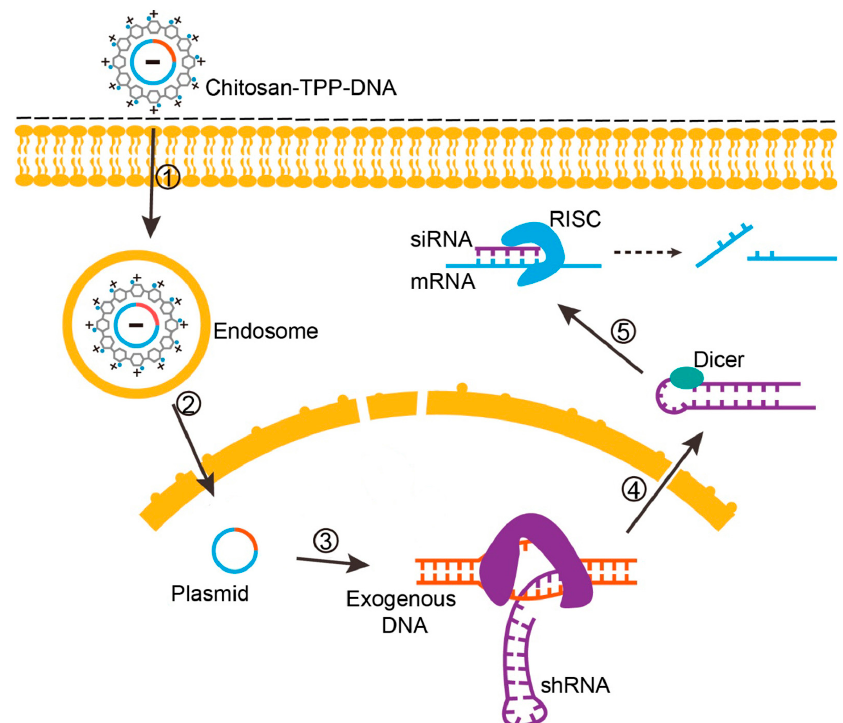
Figure 5. Cellular events associated with chitosan-based plasmid delivery for short hairpin RNA (shRNA) expression, siRNA formation and target gene silencing. 1, Cellular uptake of chitosan–DNA by endocytosis. 2, Endosomal escape of chitosan–DNA complex, plasmid dissociation from chitosan and translocation to the nucleus. 3, Transcription of plasmid (exogenous DNA) in the nucleus and generation of shRNA. 4, Transportation of shRNA to the cytosol and association with Dicer to generate siRNA. 5, siRNA association with RNA-induced silencing complex (RISC) and target mRNA by base pairing, resulting in mRNA cleavage and/or translation repression, and subsequent inhibition of protein synthesis.